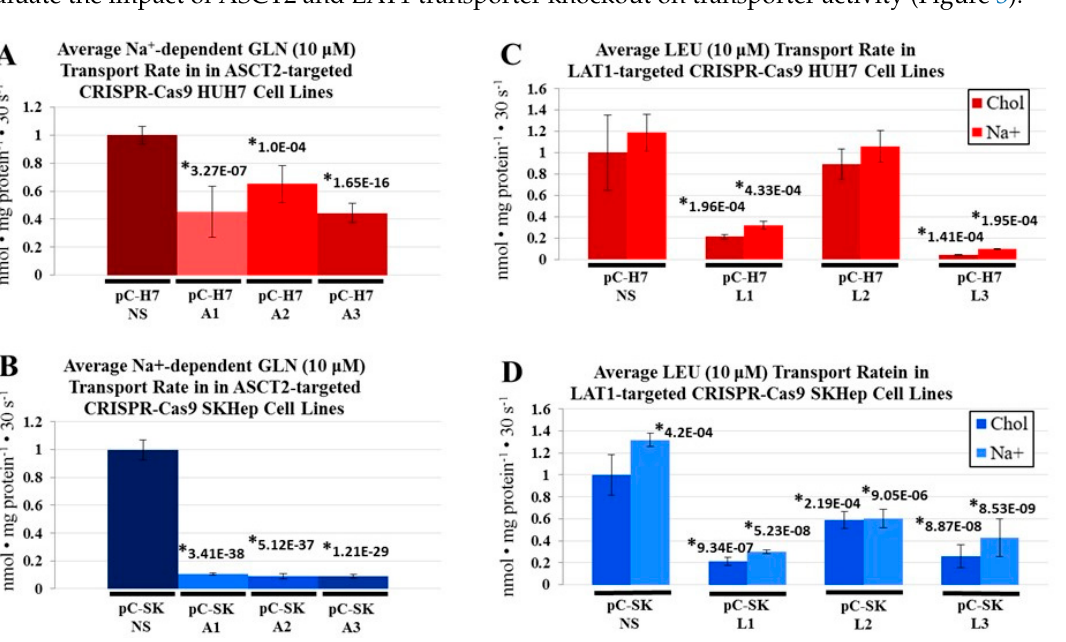
Figure 3. Na + -dependent glutamine ( L -[ 3 H]Gln) and leucine ( L -[ 3 H]Leu) initial rate uptake in CRISPR-Cas9 HUH7 and SKHep cell lines. Transport of 10 µ M L -glutamine and 10 µ M L -leucine was measured as described in Materials and Methods. Due to the Na + -dependence of ASCT2-mediated glutamine uptake, the transport values obtained in the absence of extracellular Na + (diffusion and Na + -independent uptake) were subtracted from those in the presence of Na + (total uptake) to yield Na + -dependent glutamine uptake rates depicted in graphs ( A , B ). For leucine transport, which is largely Na + -independent, transport rates in the absence (chol) and presence of Na + are shown ( C , D ). To compare transport values between cluster plates, NS controls for each parent line were set to a value of 1 and all other transport values were mathematically adjusted to reflect this change. Data are the average of at least four separate determinations ± SD. Asterisks (*) denote values that are statistically significant at p < 0.050 compared to the same values in the NS control.